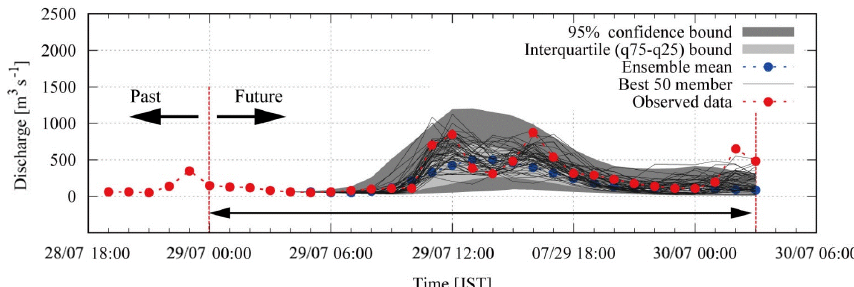
Figure 10. Hydrographs of all 1600 ensemble members, the 50 best ensemble members (NSE > 0.33) and observations.